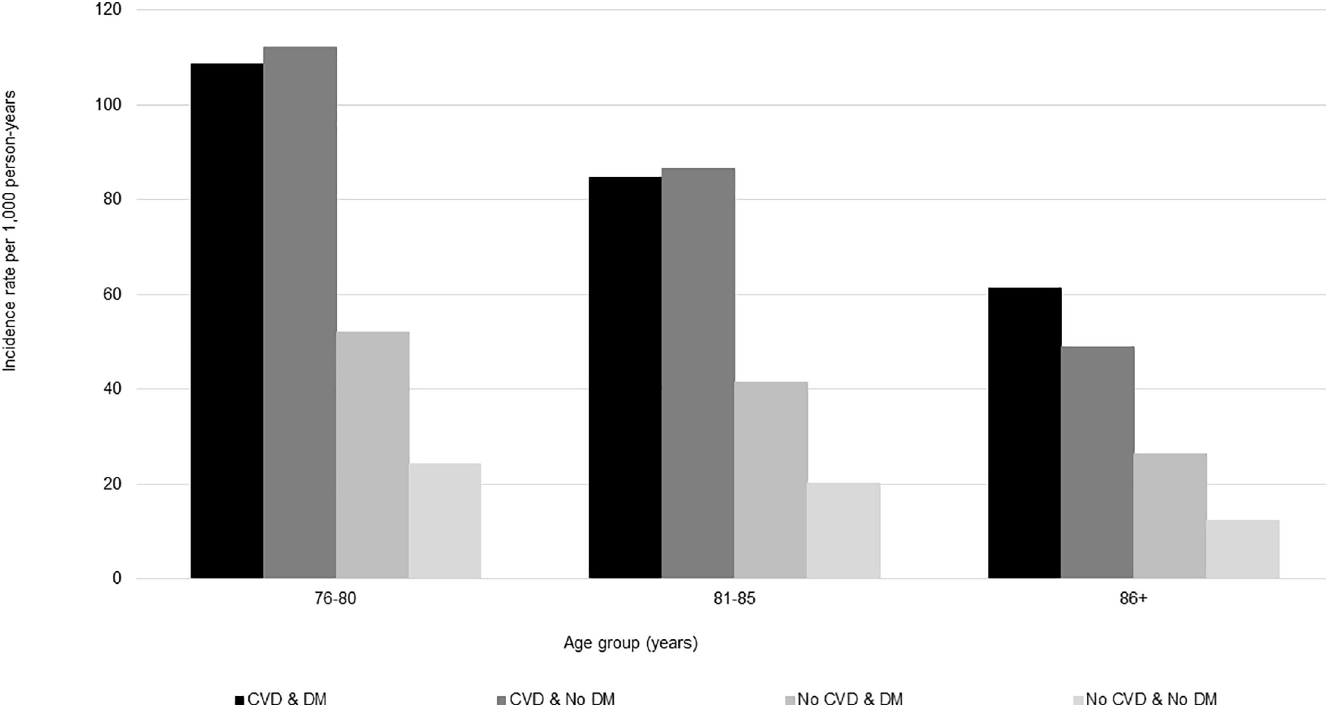
Fig 7. Statin initiation rates among older adults aged > 75 years with and without cardiovascular disease and diabetes mellitus by age group, and who go on to use statins long-term, � NIH Collaboratory Distributed Research Network, January 1, 2008- March 31, 2018. Abbreviations: CVD = cardiovascular disease; DM = diabetes mellitus � Long-term use was defined as a minimum of 180 days of statin exposure based on the number of days supplied, allowing for gaps of up to 30 days and including an exposure episode extension period of 30 days.